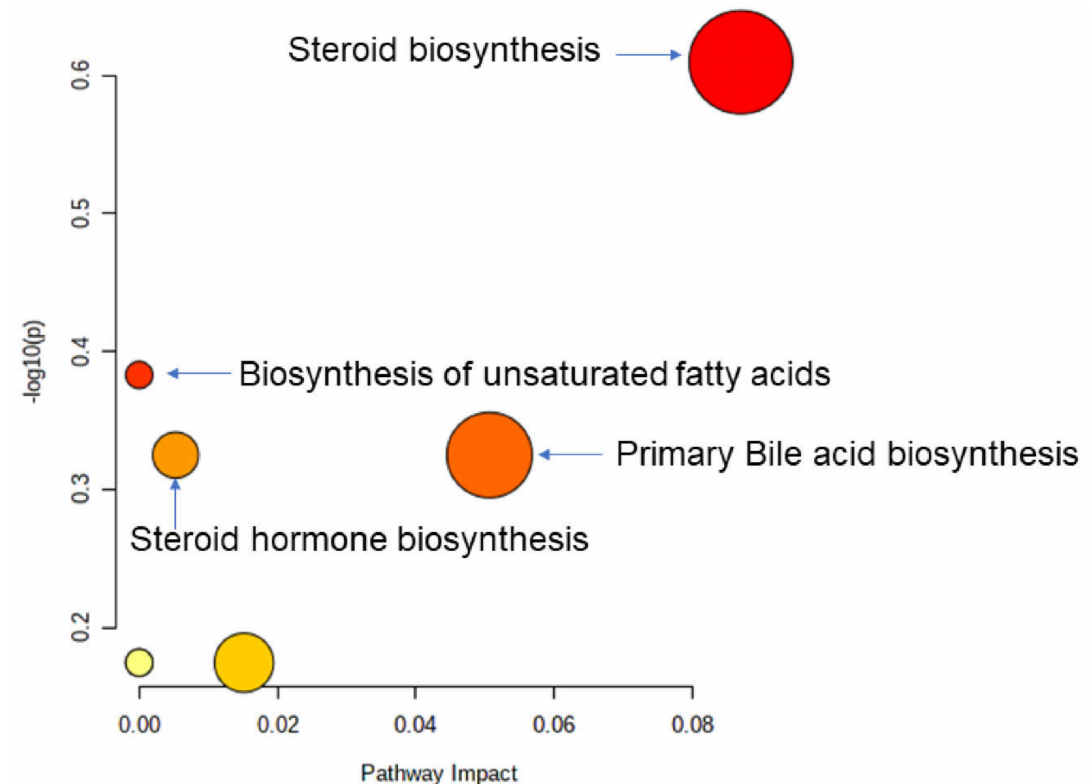
Figure 9. Summary of the pathway analysis with MetPA where all the metabolites were considered. The area of the bubbles is proportional to the effect of each pathway, with the color denoting the significance, from highest in red to lowest in